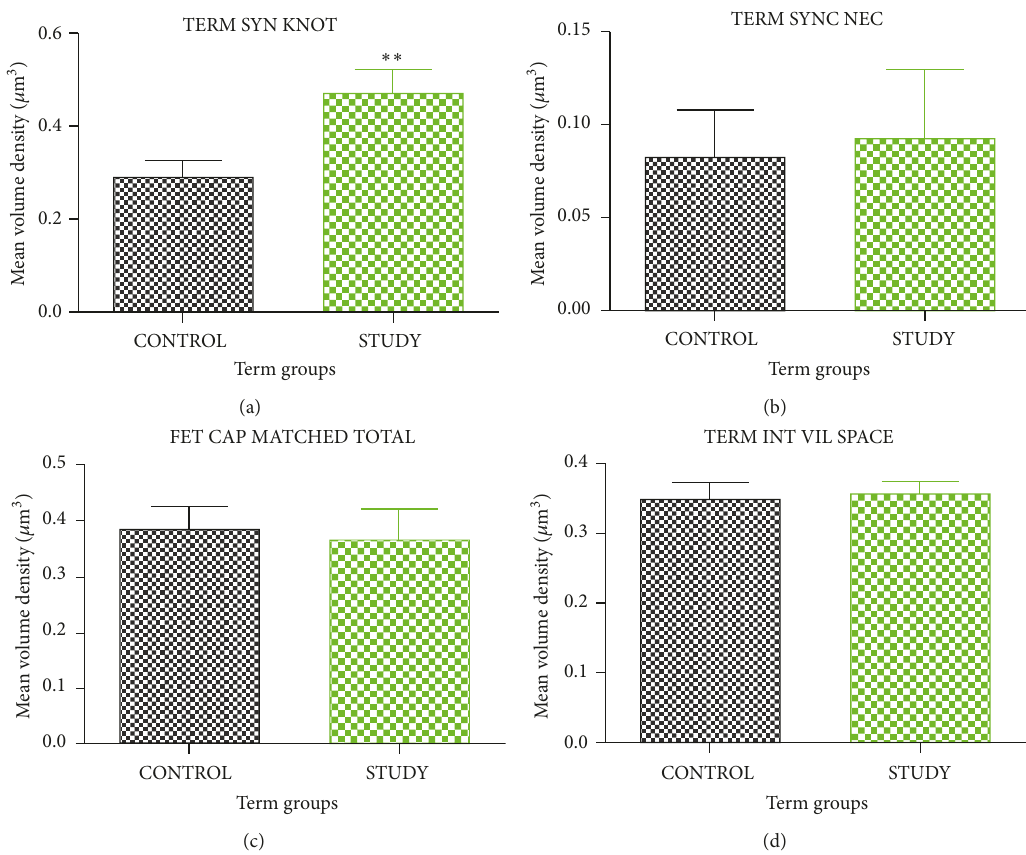
Figure 4: Unpaired t-test analysis of placental parameters at term, comparing healthy (control) and Plasmodium -infected placenta (study group). (a) Volume density of syncytial knot. (b) Volume density of syncytial necrosis. (c) Volume density of foetal capillaries. (d) Volume density of intervillous space. SYN KNOT represents syncytial knot, SYNC NEC represents syncytial necrosis, FET CAP represents foetal capillaries, and INT VIL SPACE represents intervillous space. Values are expressed as mean ± SEM. P value represents significance level for unpaired t -test for time course assessment for term group comparison with ∗ =P < 0.05, ∗∗ =P < 0.01, and ∗∗∗ =P <